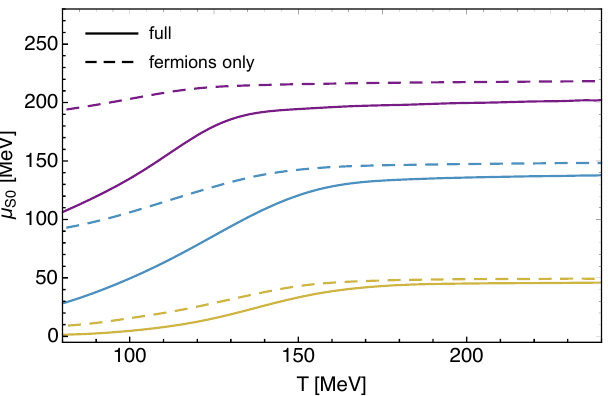
Figure 5: Comparison between our full result for µ = 150, 450 and 660 MeV (from bottom to top). The color coding for µ lines) for µ B is the same as in Fig.